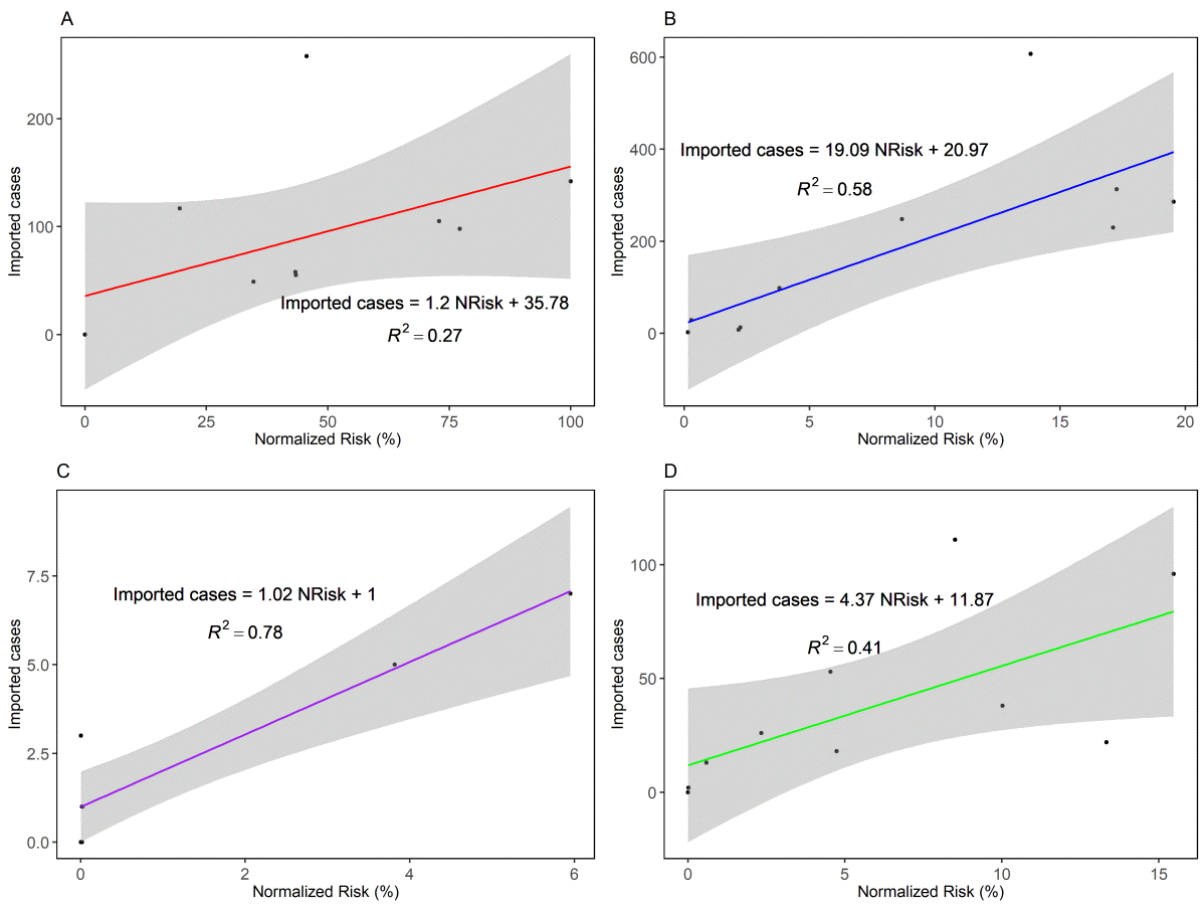
Figure 4. Regression analysis between the imported cases in South Korea from (A) North America, (B) Asia (except China), (C) China, and (D) Europe, and normalized risk (%). The dots indicate the number of imported cases in South Korea and solid lines represent the fitted linear regression. NRisk: normalized